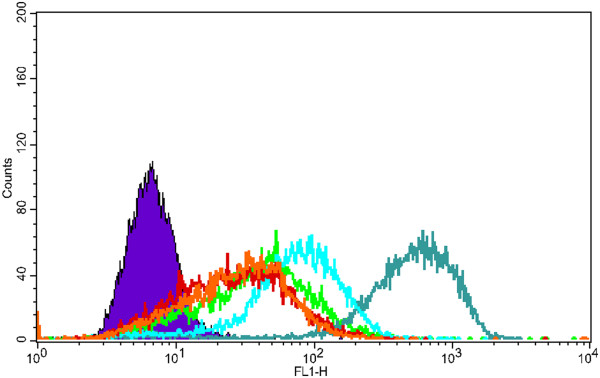
Charge-induced differences in uptake. Incubation of NR-MSPs in HeLa cells at a low concentration (1 μg/ml), NR-MSP (green, 83.6%), NR-MSP-PEI-ACA (red, 62.4%), NR-MSP-PEI-SUCC (orange, 69.6%), NR-MSP-PEI adsorbed (light blue, 93.2%), NR-MSP-PEI grafted (teal, 97.9%) and control (violet).